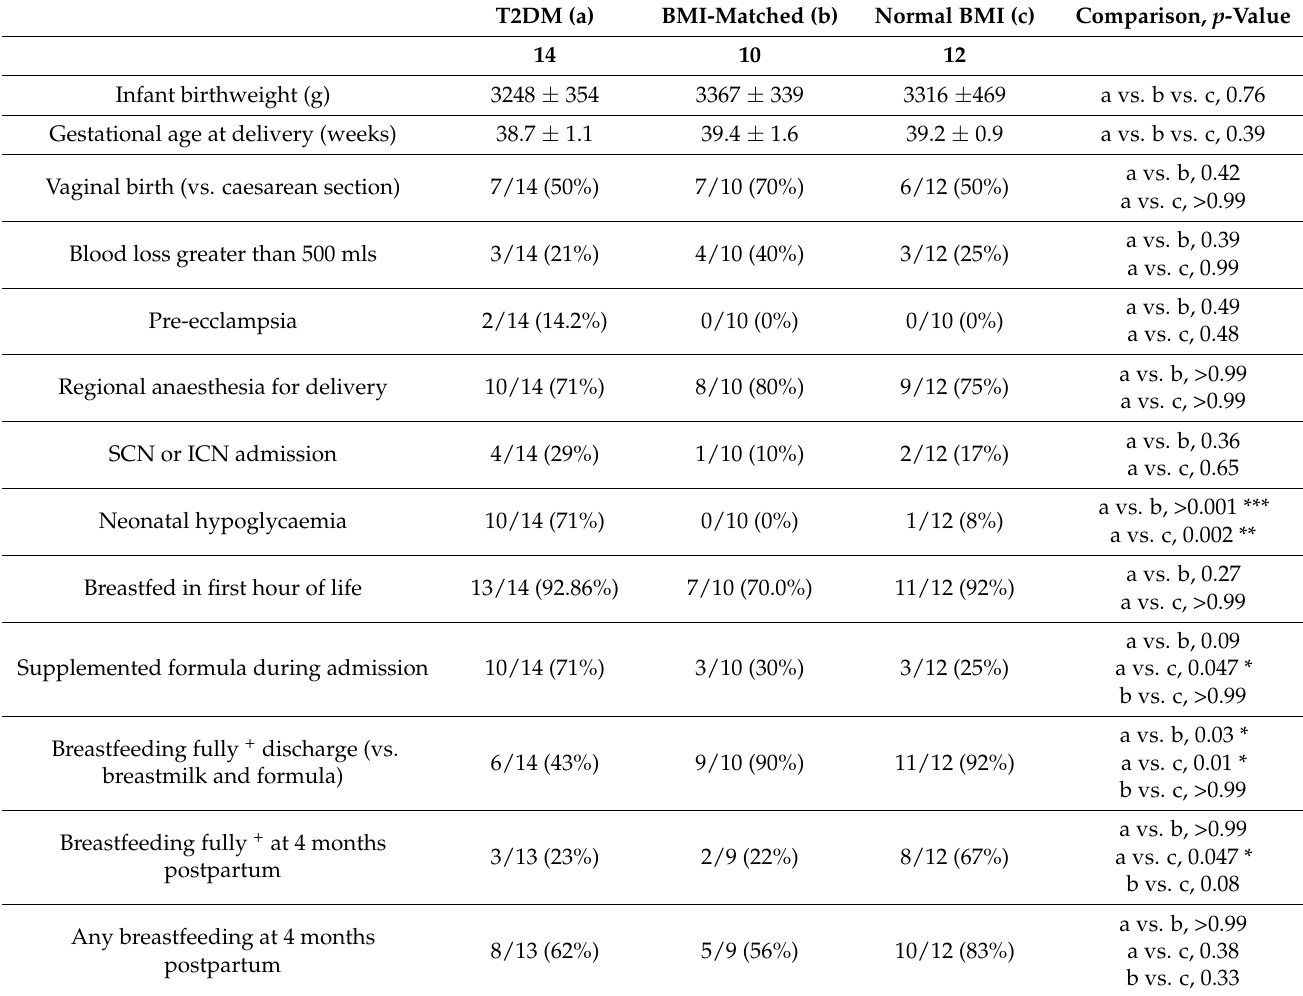
Table 2. Post-Delivery Data: Women Who Provided Breastmilk for